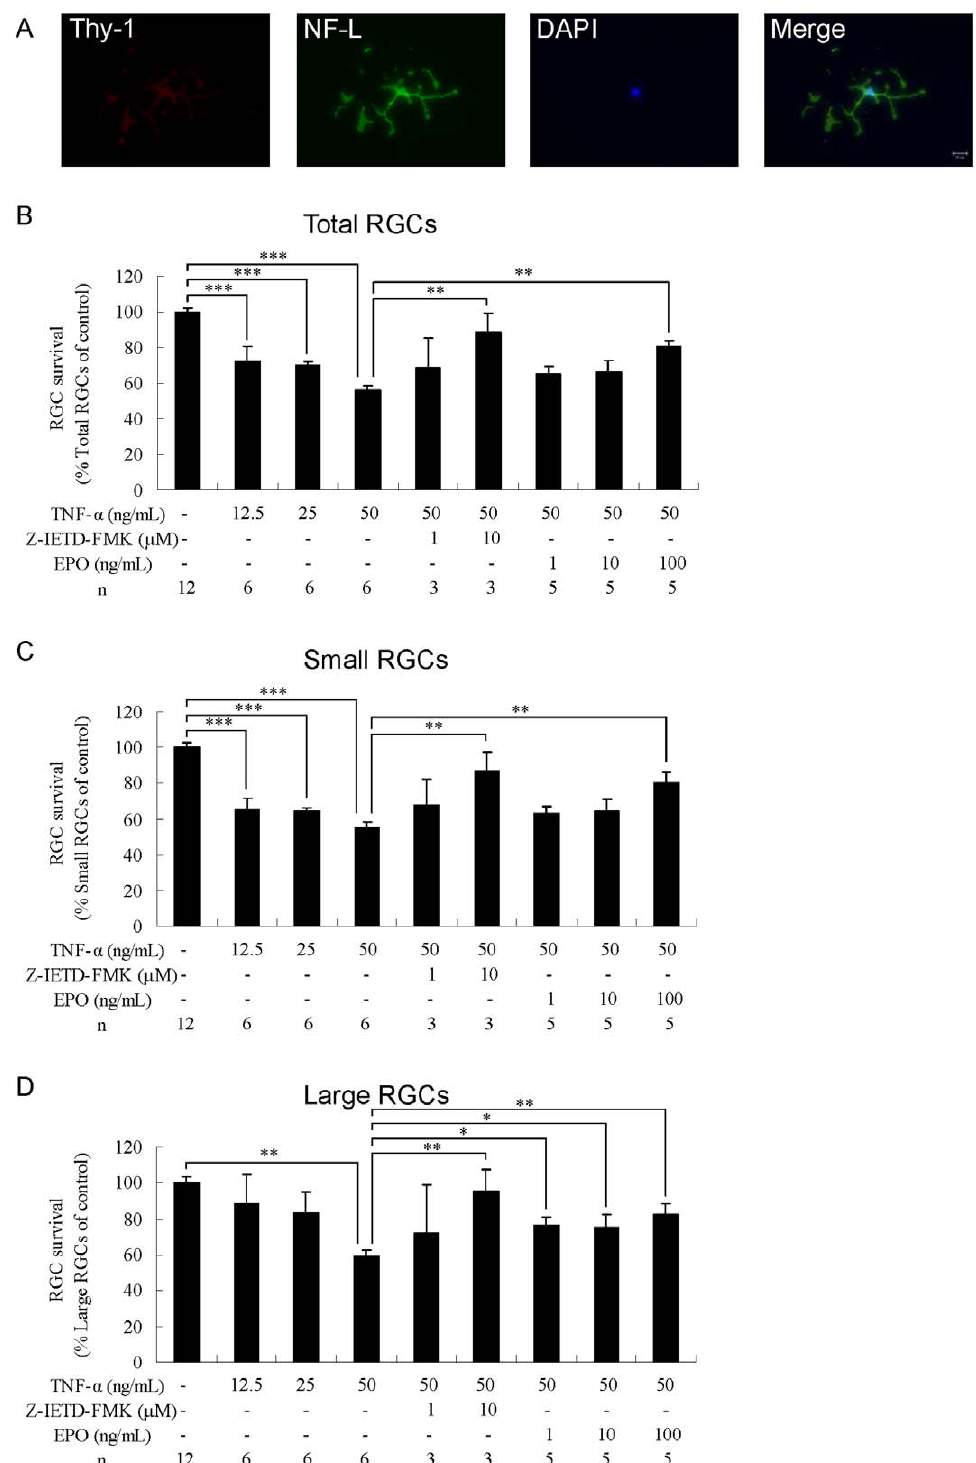
Figure 4. Effects of erythropoietin on total, small, and large RGCs under TNF- a -induced toxicity. (A) Morphology of TNF- a -treated RGCs. The cells were cultured in a medium supplemented with 50 ng/mL TNF- a . After culturing, RGCs were immunostained with anti-Thy-1 antibody (red), anti-NF- L antibody (green), and DAPI nuclear staining (blue). Survival rate of (B) total, (C) small, and (D) large RGCs. The cells were treated with a vehicle: TNF- a (12.5–50 ng/mL) alone, TNF- a (50 ng/mL) + Z-IETD-FMK (1 or 10 m M), or TNF- a (50 ng/mL) + EPO (1–100 ng/mL). The number of RGCs was counted and normalized versus the control group. Data are presented as mean 6 standard error of the mean (n=3–12). Data were statistically analyzed by 1-way ANOVA, followed by Dunnett’s test. *P , 0.05, **P , 0.01 and ***P , 0.001.